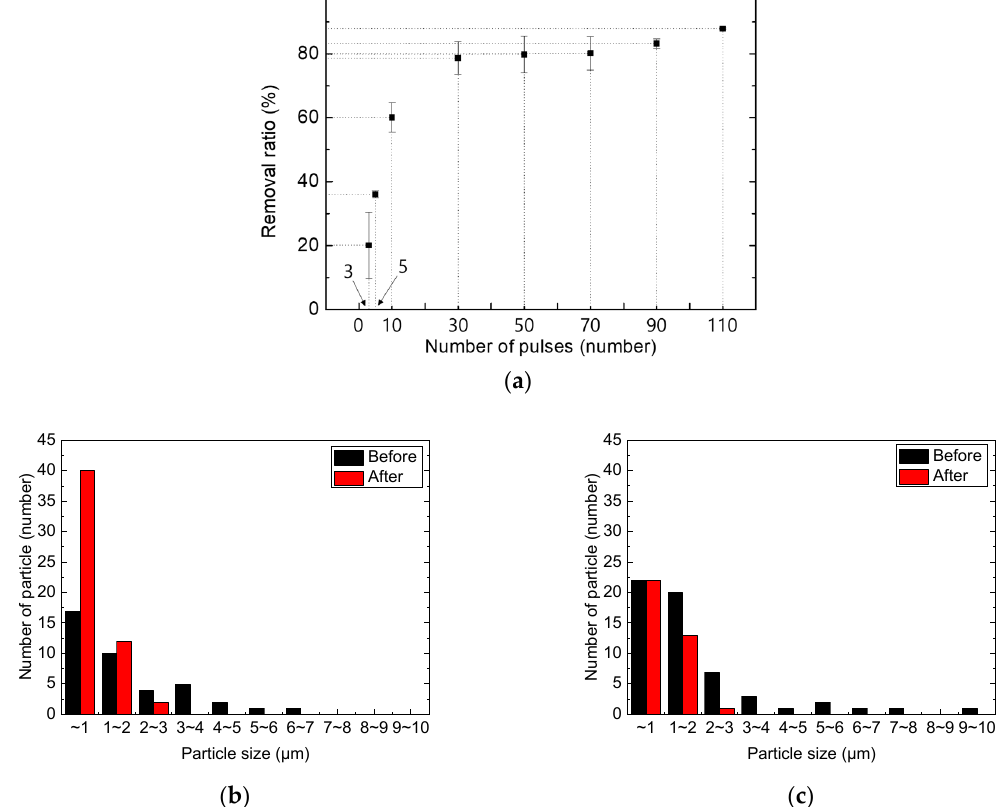
Figure 10. ( a ) Particle removal ratio with number of pulses. ( b , c ) Change in particle distribution after LSC process with different pulse numbers: ( b ) pulse number = 30; ( c ) pulse number = 110.